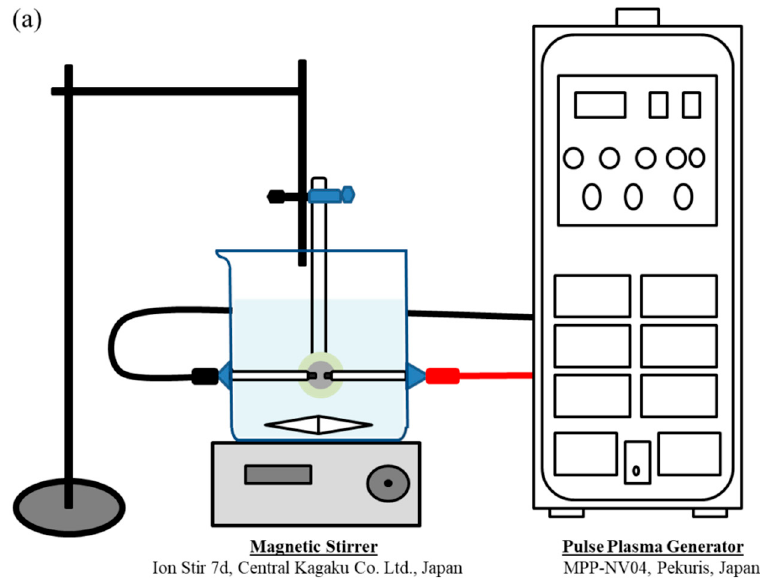
Figure 1. Cont. Figure 1.